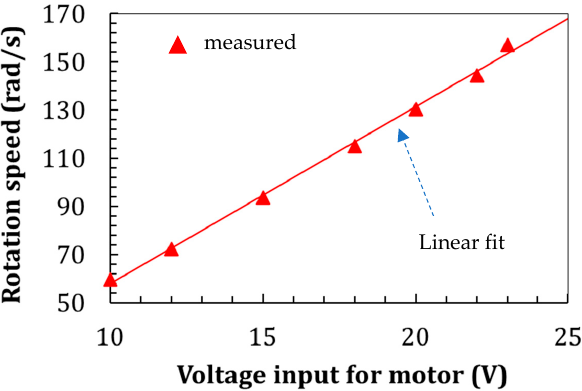
Figure 8. The motor’s supply voltage and rotation speed are linear relationships.